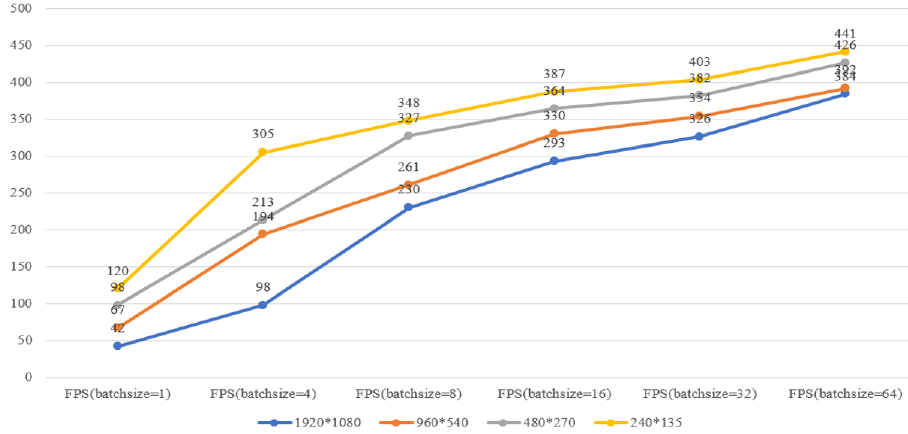
Figure 8. Comparison of training loss of different models: Here, loss1 represents our method in this study; loss2 represents the traditional DeepLab v3+ result; loss3 represents the DenseNet result; loss4 represents the SegNet result; loss5 represents the U-Net result; loss6 represents the FCNNs result.